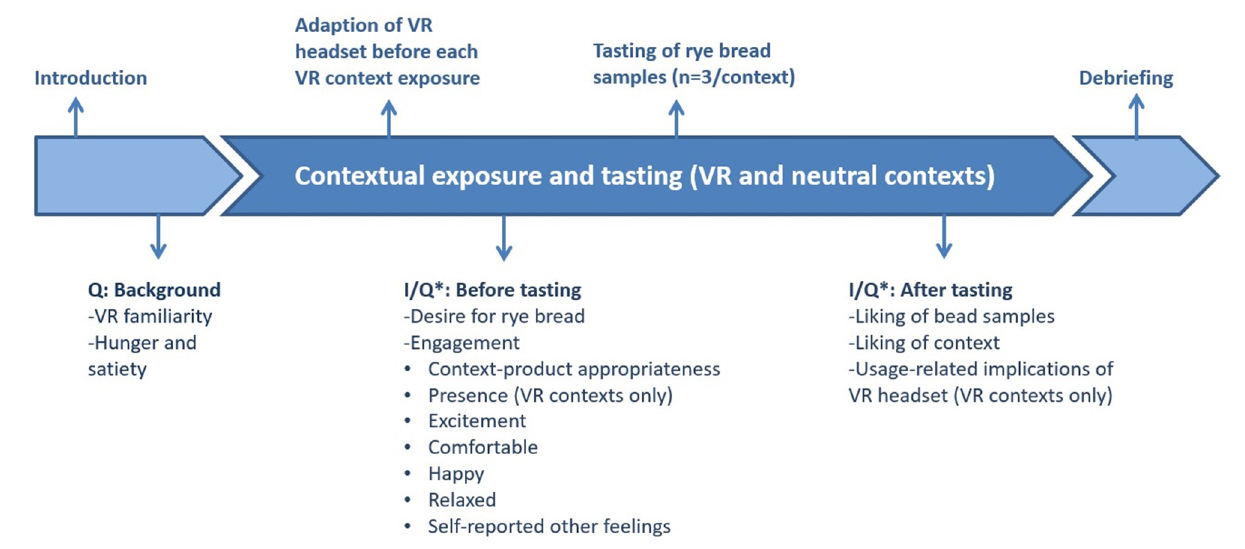
Figure 4. Illustration of the sequence of measuring responses in the given context. Each participant experienced three contexts and tasted rye bread samples in each context. Q = self-reported question- naire; I/Q* = interview during VR context exposure and self-reported questionnaire used during the neutral context; VR = virtual-reality-immersed restaurant context and cinema context.